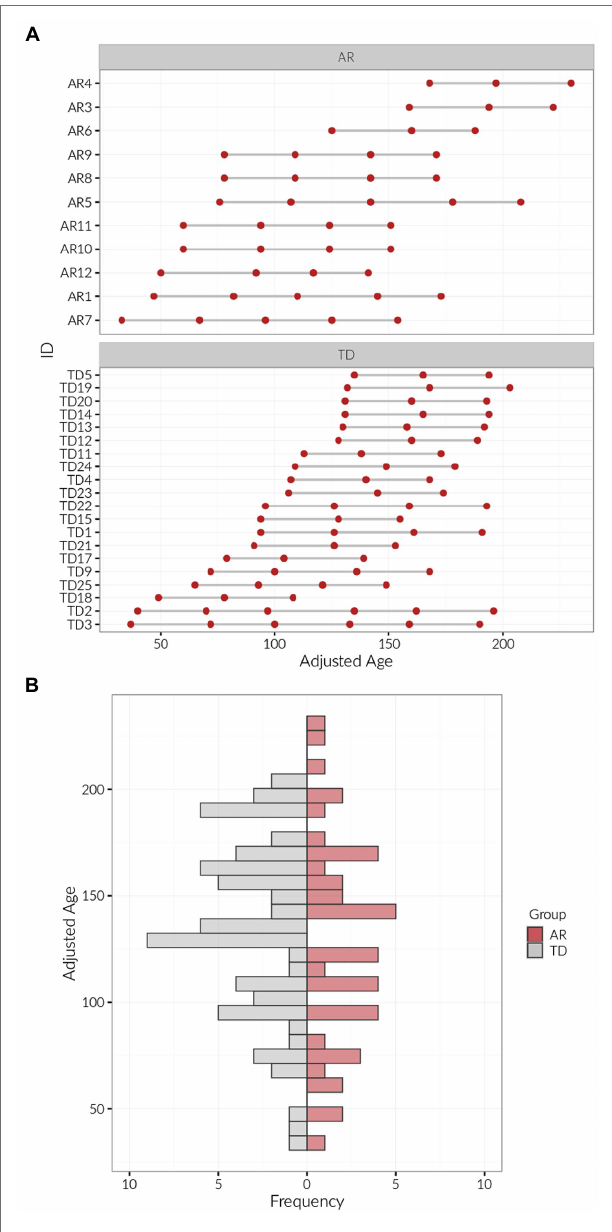
FIGURE 1 | Timepoints and frequency of visits for infants at risk (AR) and with typical development (TD) collected during the development of reaching. (A) Each red dot represents a measurement, plotted against adjusted age. (B) Distribution of ages of AR and TD groups was noted to be roughly